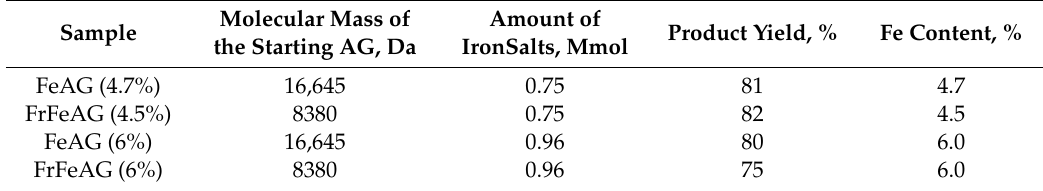
Table 1. Di ff erent compositions of ferroarabinogalactans (FeAGs).